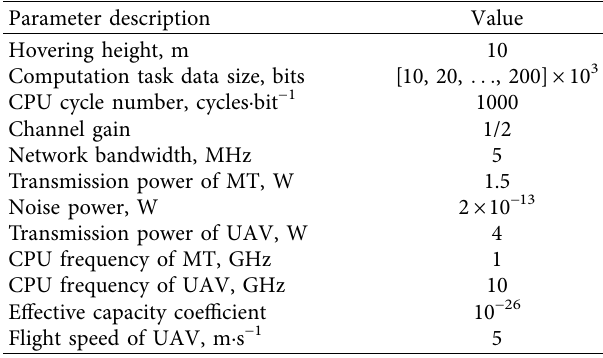
Table 1: Main simulation parameters.